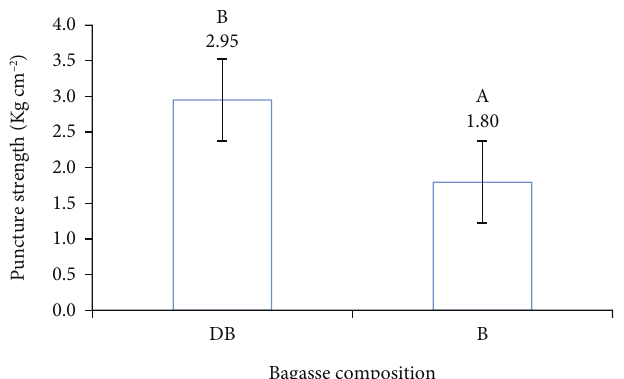
Figure 9: E ff ect of raw material composition of depithed bagasse (DB) and bagasse (B) on the puncture strength of biofoam cup (values followed by the same letter indicate nonsigni fi cant di ff erences).